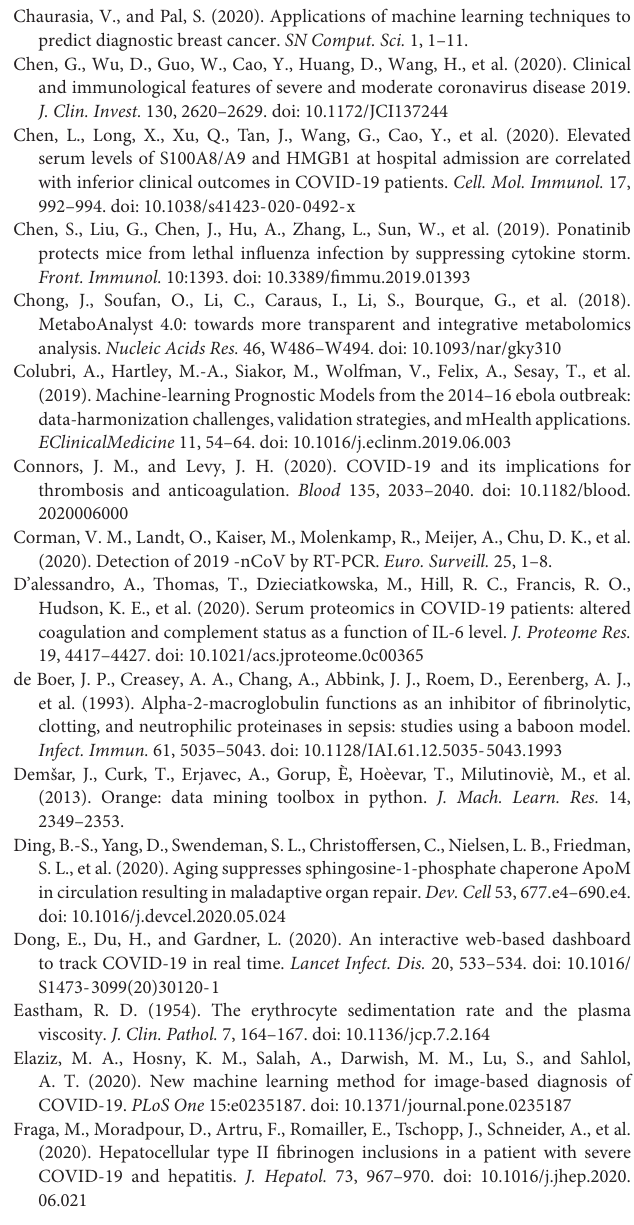
Supplementary Table 6 | List of peptides and transitions used for MRM analysis. Supplementary Table 7 | List of proteins involved in the enriched pathways. Supplementary Table 8 | List of FDA approved, Clinical and Pre-clinical drugs used in docking study. Supplementary Table 9 | The potential drug binding to proteins up-regulated in COVID-19 severe. Supplementary Table 10 | The list of potential drug binding to the target proteins. Supplementary Table 11 | The list of proteins selected for docking. Supplementary Table 12 | The potential drugs binding to proteins upregulated in COVID-19